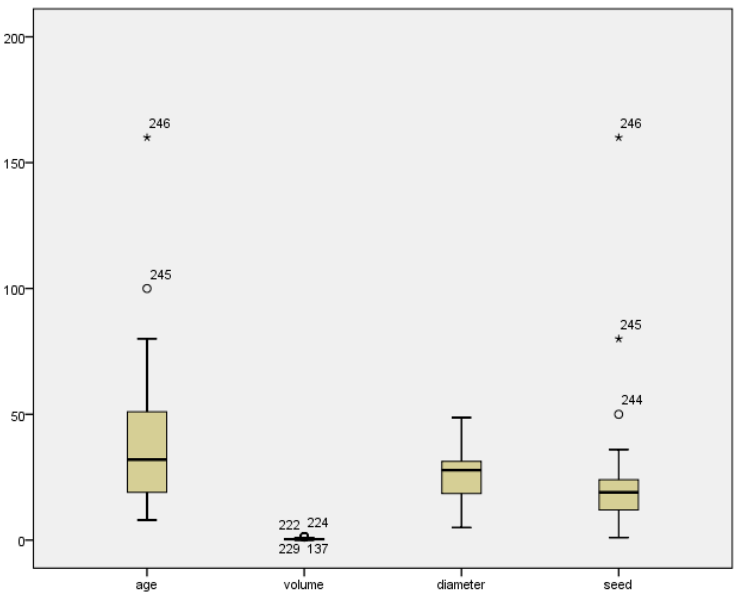
Figure A1. The box plot of data of 246 Pistacia chinensis .